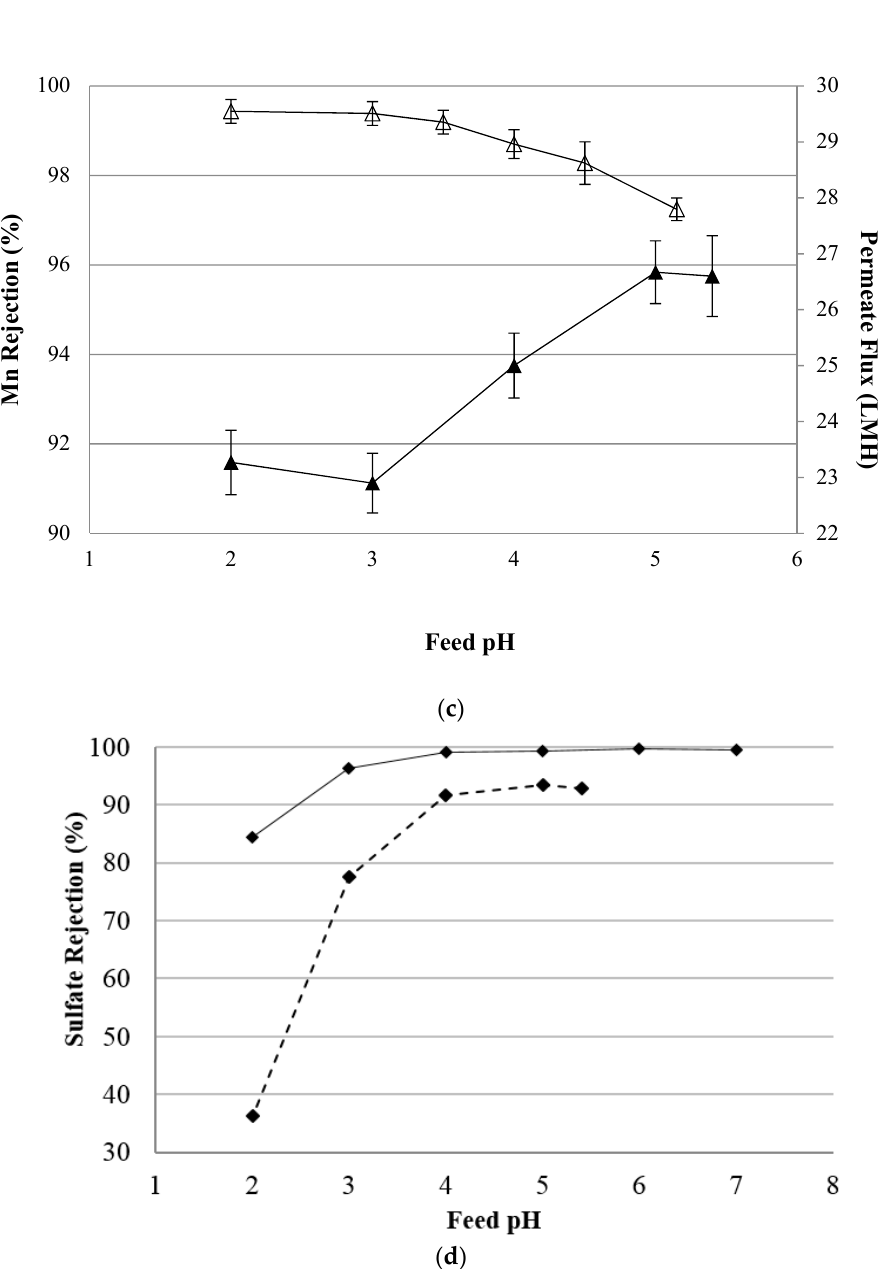
Figure 3. ( a ) Effect of feed pH on magnesium rejection (open symbol) and permeate flux (closed symbol). (Experimental conditions: MgSO 4 = 4000 mg/L, feed pressure = 10 bar, T = 25 °C). ( b ) Effect of feed pH on copper rejection (open symbol) and permeate flux (closed symbol) (Experimental conditions: CuSO 4 = 100 mg/L, feed pressure = 10 bar, T = 25 °C). ( c ) Effect of feed pH on apparent manganese rejection (open symbol) and permeate flux (closed symbol). (Experimental conditions: Mn(NO 3 ) 2 = 165 mg/L, feed pressure = 10 bar, T = 25 °C). ( d ) Effect of feed pH on apparent sulfate rejection. Feed solution containing 4000 mg/L MgSO 4 (full line) and 100 mg/L CuSO 4 (dotted line). (Experimental conditions: feed pressure = 10 bar, T = 25 °C).